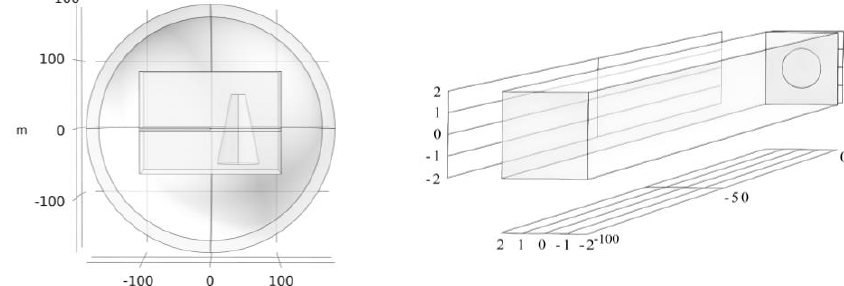
Figure 6. Geoelectric model of a full − space sphere. Table 1. Geoelectric parameters of the model.